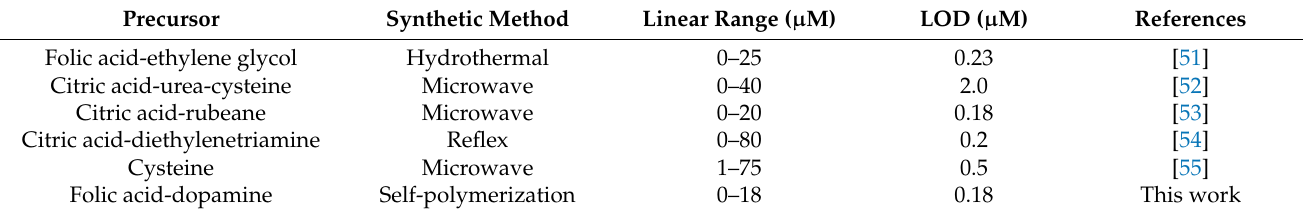
Figure 8. ( a ) Fluorescence emission spectra of the FA-PDA FONs probe with the addition of varying Hg 2+ concentrations. ( b ) The relationship between the (I 0 − I)/I 0 ratio and the Hg 2+ concentration in the 0–100 µM range. The inset shows the linear relationship between the (I 0 − I)/I 0 ratio and the Hg 2+ concentration in the 0–18 µM range. The regression equation was y = 0.03832x − 0.01093. Table 1. Comparison of different CDs-based probes towards Hg 2+ .